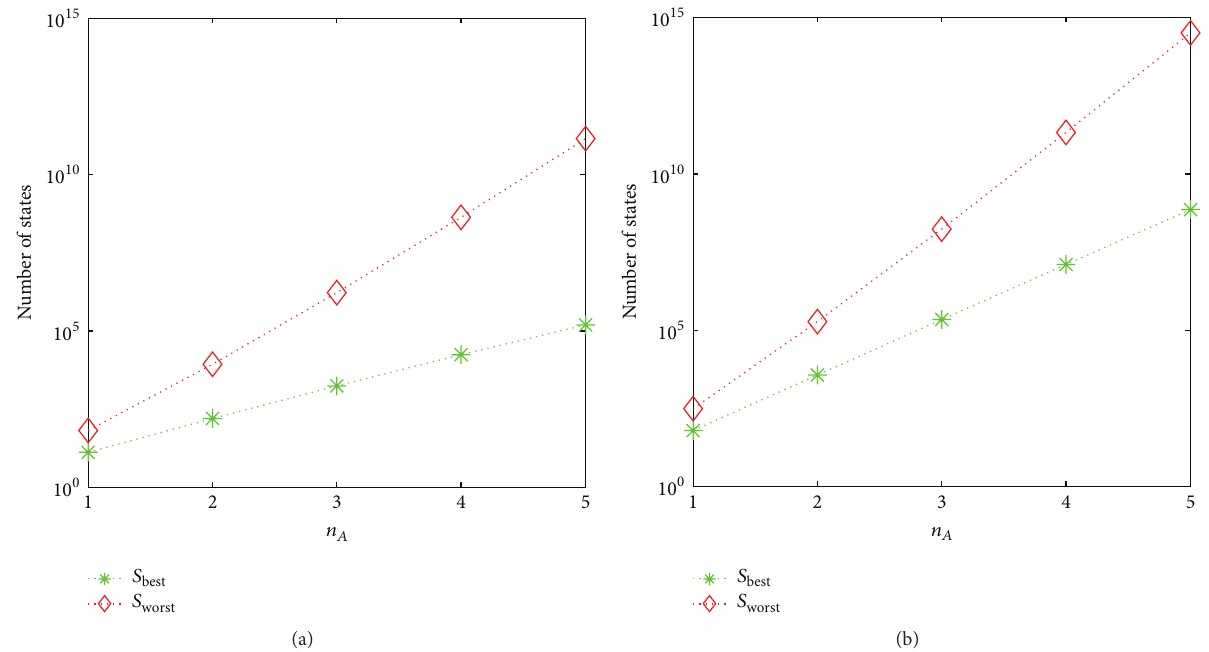
Figure 8: The growth trend of states 𝑆 following 𝑛 𝐴 under different movement points. (a) Movement point: 2, movement cost: 1; (b) movement point: 5, movement cost: 1.